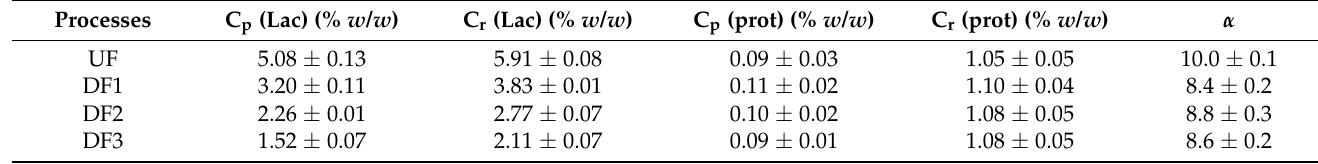
Table 5. Separation factors (1) ( α ) between lactose and protein, along with UF/DF processes for membrane ETNA01PP. Processes C p (Lac) (% w/w